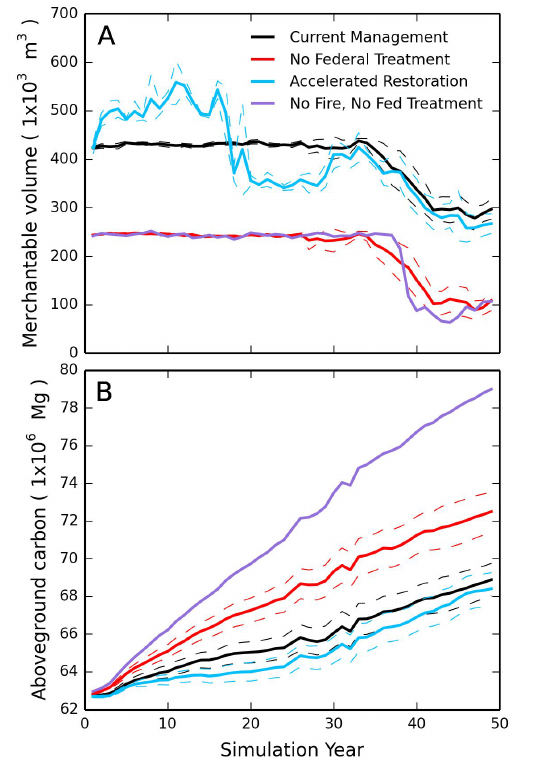
Fig. 8. Mean merchantable volume for the U.S. Forest Service (A), Warm Springs Tribe (B), corporate owners (C), and family forest owners (D) over time for different management scenarios. Broken lines indicate corresponding 95% confidence intervals for 15 replications.